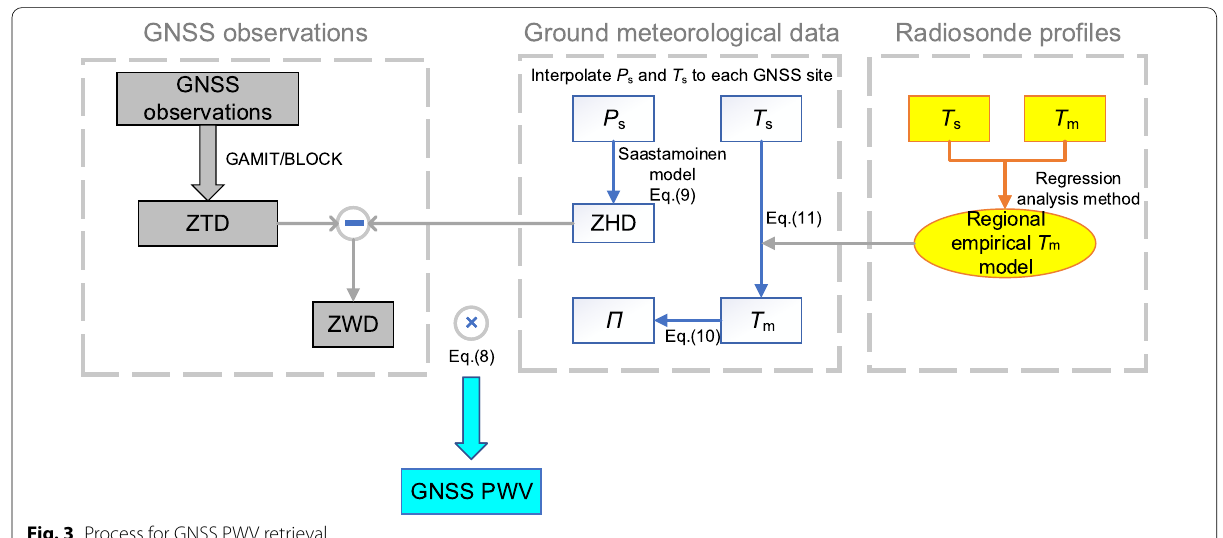
Fig. 3 Process for GNSS PWV